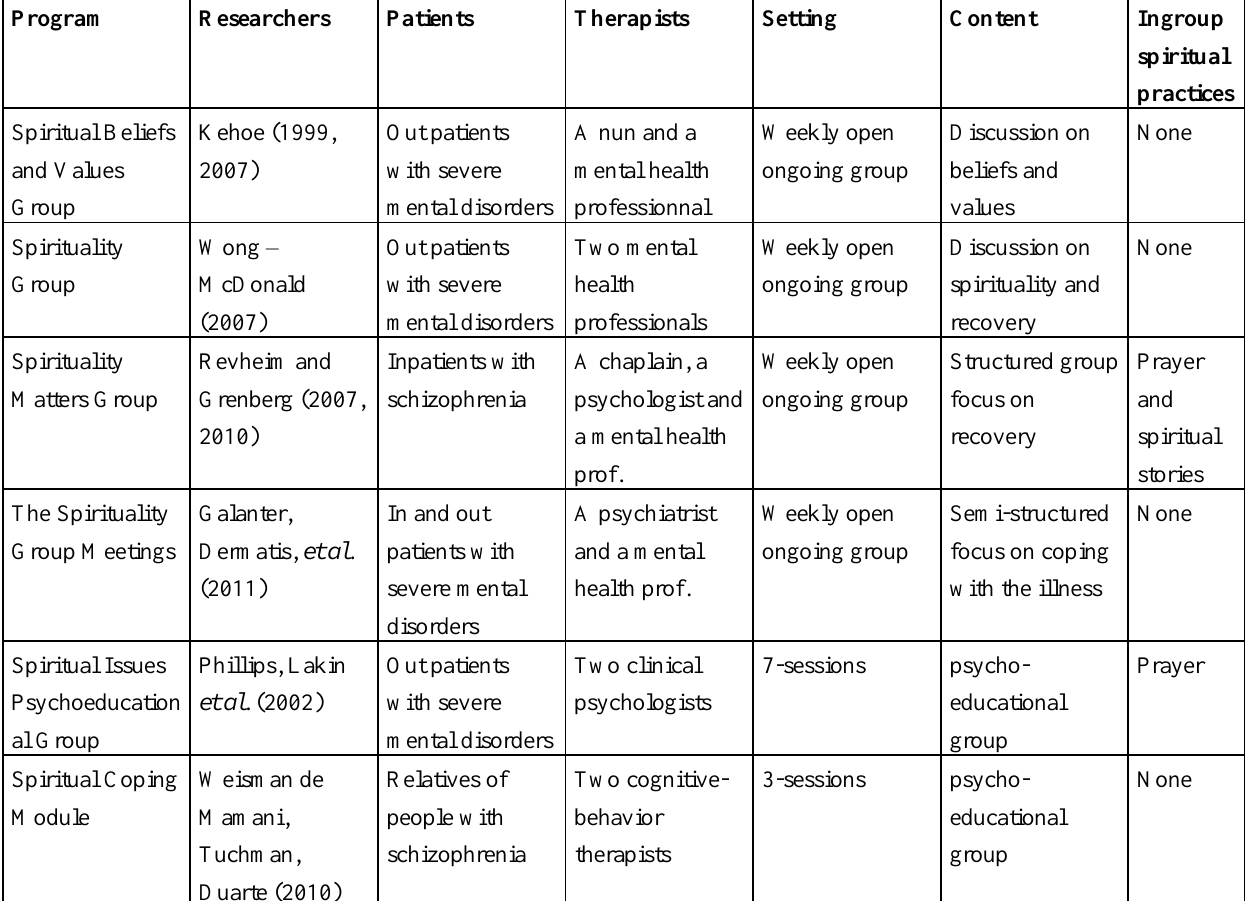
Table 1. Spiritual Groups for severe mental